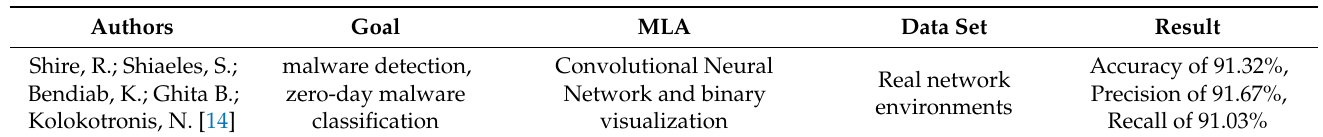
Table 1. Machine learning algorithm (MLA) efficiency for cyberattack detection in the Internet